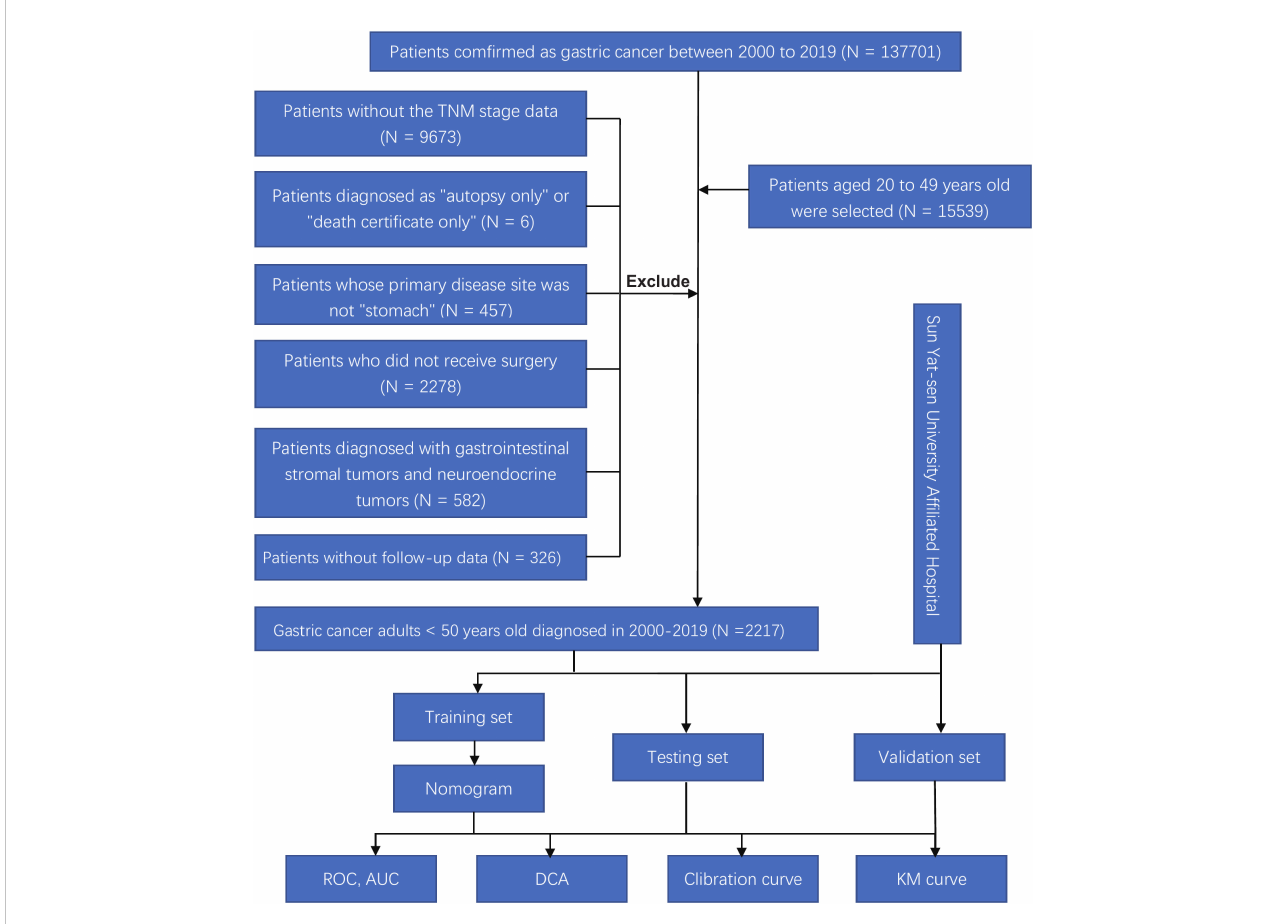
FIGURE 1 Flow chart of this study. ROC, receiver operating characteristic; AUC, area under the curve; DCA, and decision curve analysis; KM curve, Kaplan-Meier